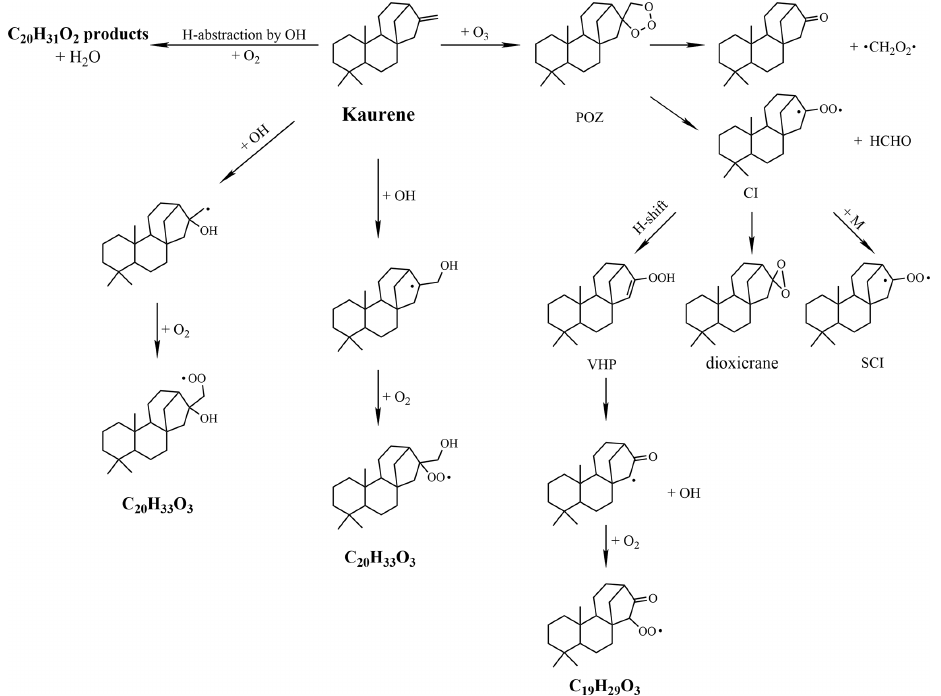
Figure 3. Simplified mechanism of the formation routes of the primary RO 2 from kaurene–O 3 and kaurene–OH reactions. POZ: cyclic primary ozonide; CI: Criegee intermediates; SCI: stabilized Criegee intermediates; VHP: vinyl